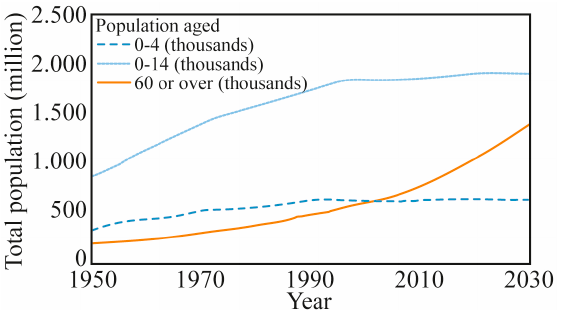
Figure 1. World population ageing throughout the years and predictions for the next 10 years, adapted from [18].